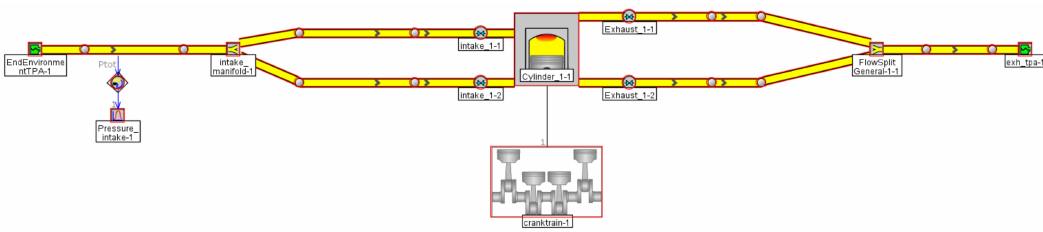
Figure 5. Optical engine model built in GT-Power.